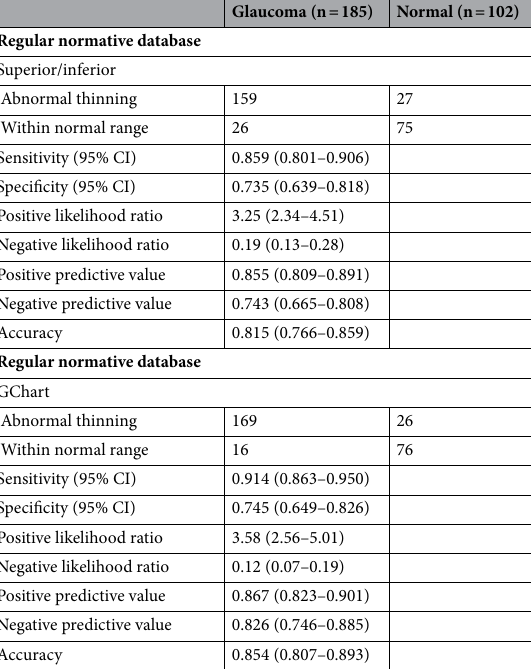
Table 4. Discriminating ability of the regular normative database on macular ganglion cell complex thickness for glaucoma detection. CI Confidence Interval.